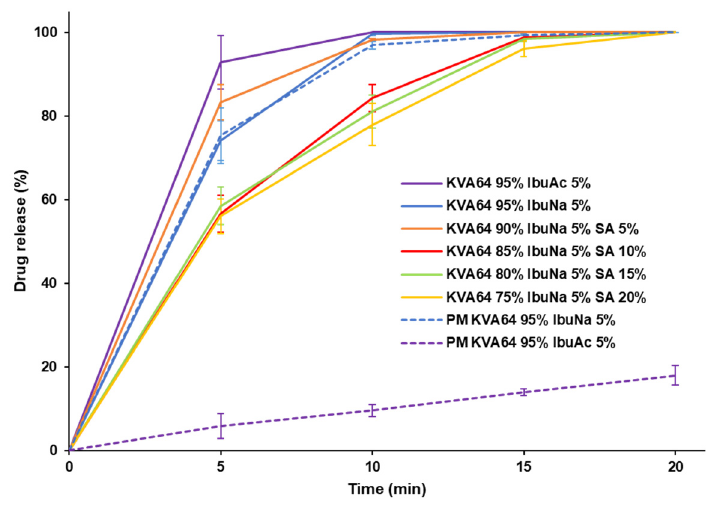
Figure 8. Dissolutions profiles of the different SOFs prepared with drugs and the physical mixtures of KVA64 95%/IbuNa 5% and KVA64 95%/IbuAc 5%.